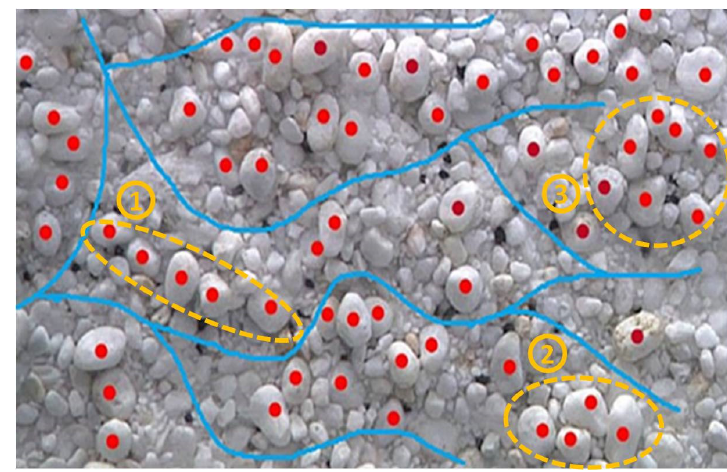
Figure 8. Bed surface profile of armored bed with clusters and “flow-accelerating belts”. Red points represent the visible largest particles of d m = 17 mm (three typical shapes of clusters bounded by dotted yellow circles, and labeled by ① line, ② heap, ③ ring, respectively), and the blue lines are drawn along flow belts (water flows from left to right).